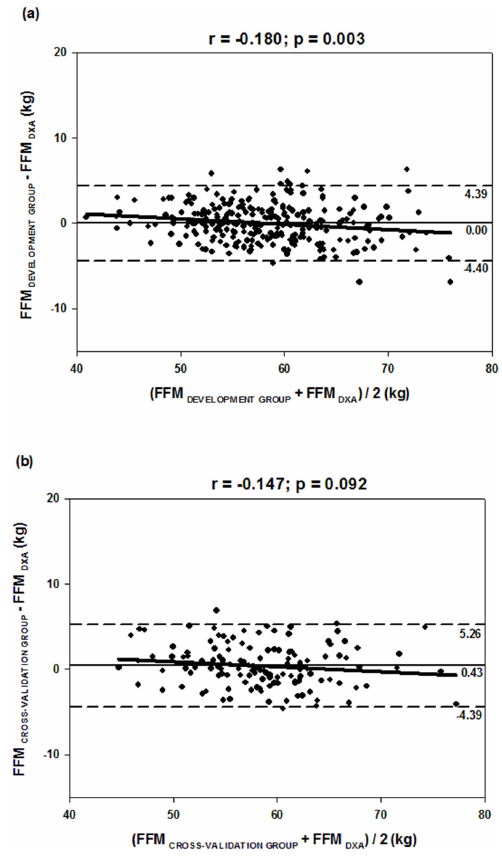
Figure 2. Bland–Altman plots of the agreement between values of FFM determined by the reference method (DXA) and estimated by BIA-specific equations: development group (1); and cross-validation group (2). Solid black line: mean of the differences; dashed line: limits of agreement of 95%; continuous gray line: correlation ( r ) between the average and the differences of the methods.